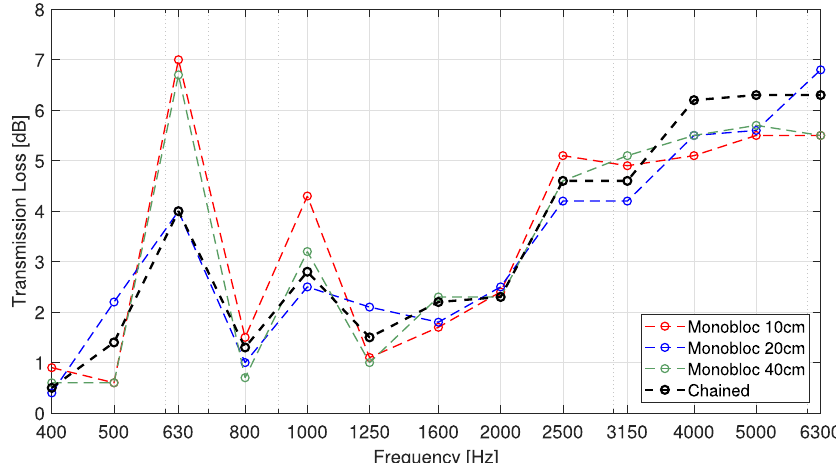
Figure 9. Transmission loss due to the association of 2 rigid expansion chambers. Results are averaged over the 1/3-octave frequency band.